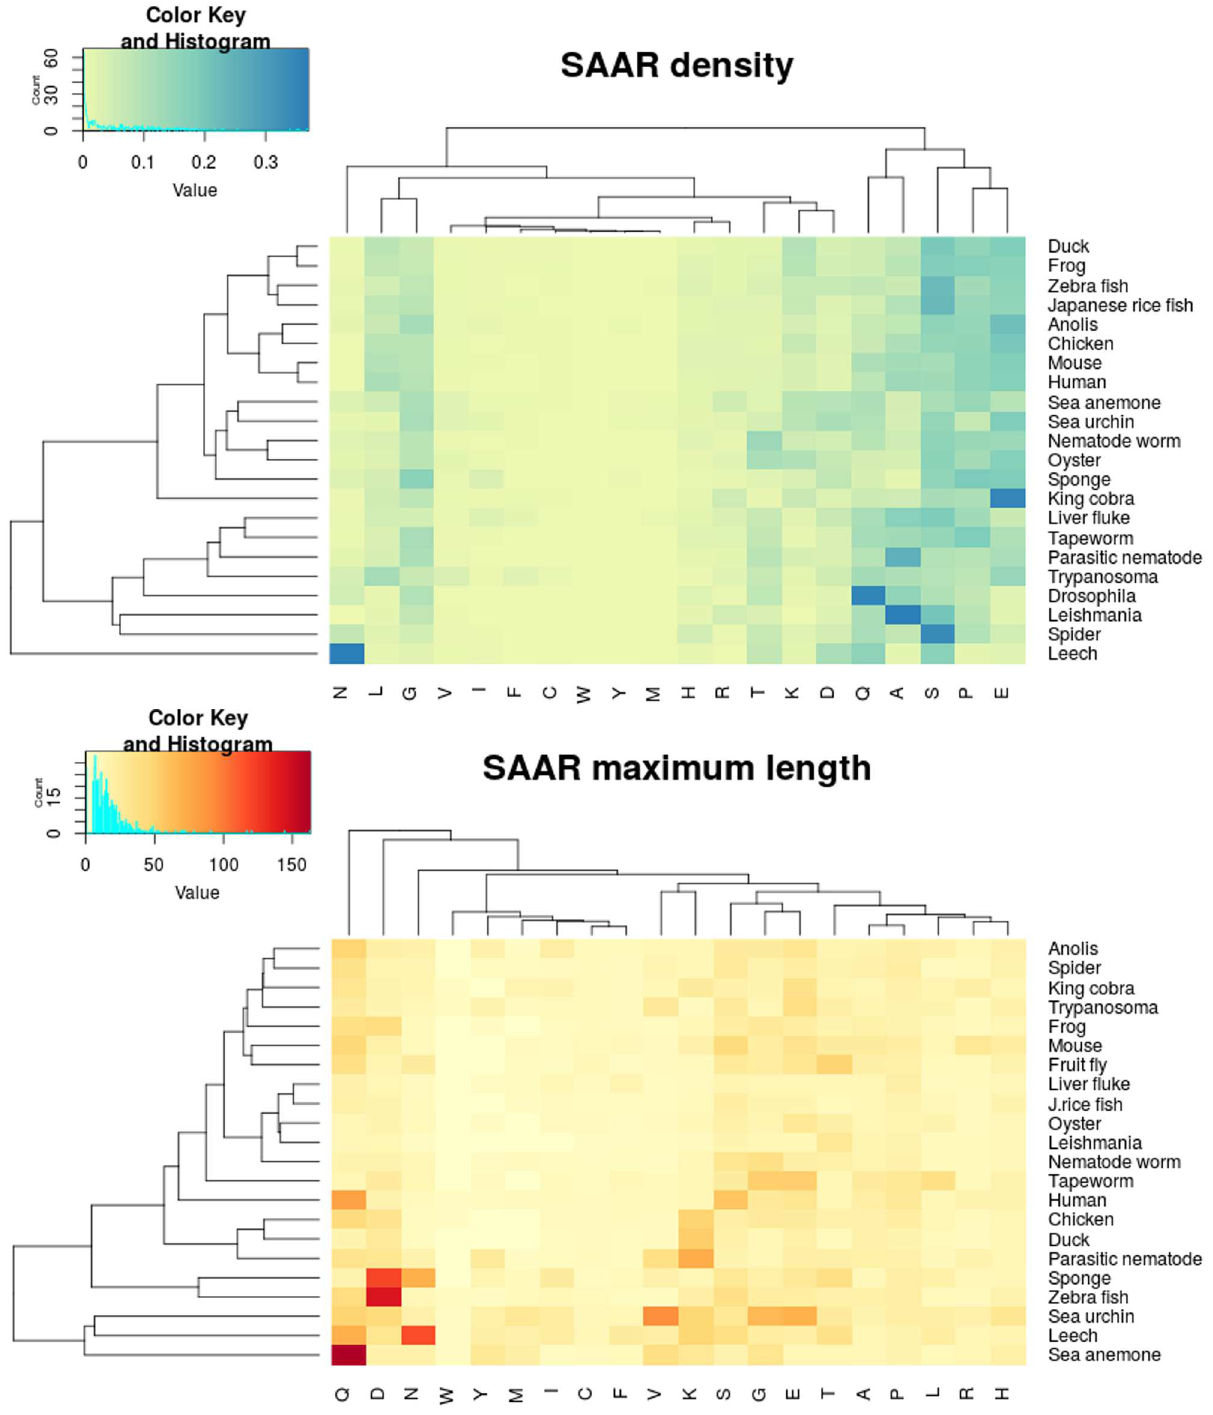
Fig 5. SAAR density and longest SAAR among all proteomes. (A) SAAR density was calculatedand normalized to one millionresidues for the indicatedproteomes and plotted as a heatmapwhere the X-axes show individual amino acid associated repeats and Y-axes have all the organisms under study. The plot is two way clusteredto group amino acids and species with similar densities.(B) A heat map was generatedfor the longestrepeat length for all the amino acids in each of the vertebrate and invertebrateproteomes under study. The plot is two-way clusteredbetweenthe longestSAARs (X-axis) and the proteomes(Y-axis).